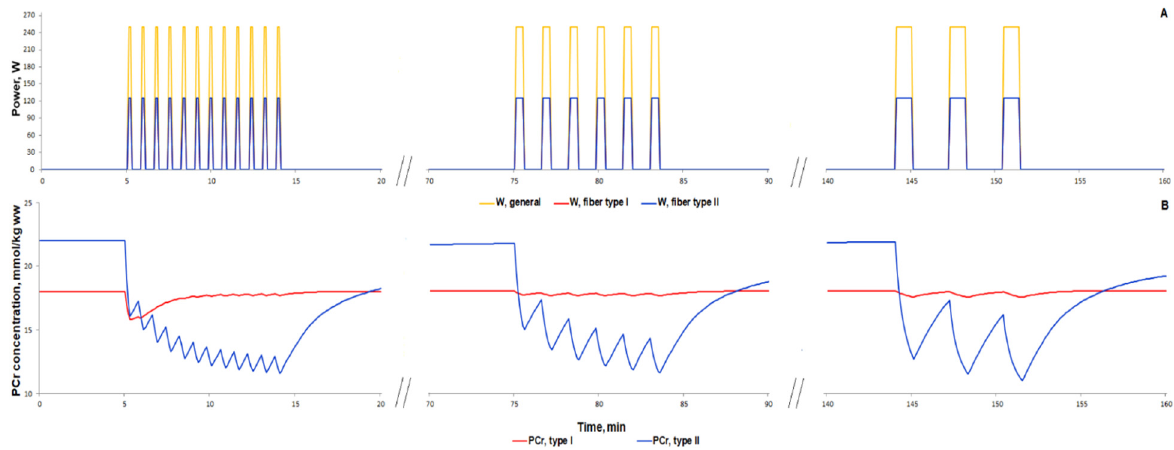
Figure 9. Simulation results for high-intensity intermittent exercise bouts with different ratios of work:recovery (initial— 16:32 s; intermediate—32:64 s; final—64:128 s) [91]. ( A ) Exercise power and fiber recruitment pattern: total power (W peak = 250) (orange), power generated by type I (red, W peak = 125) and II (blue, W peak = 125) fibers; ( B ) PCr concentration in type I (red) and type II fibers